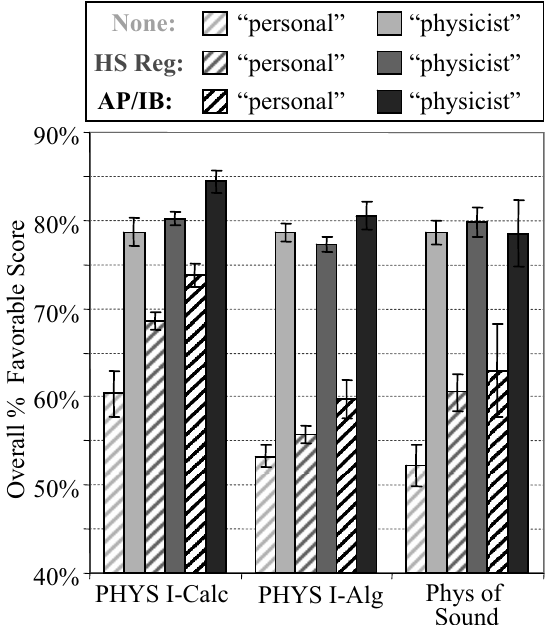
FIG. 6. Pre CLASS scores by previous and current physics courses. Error bars represent plus and minus one standard error of the mean.